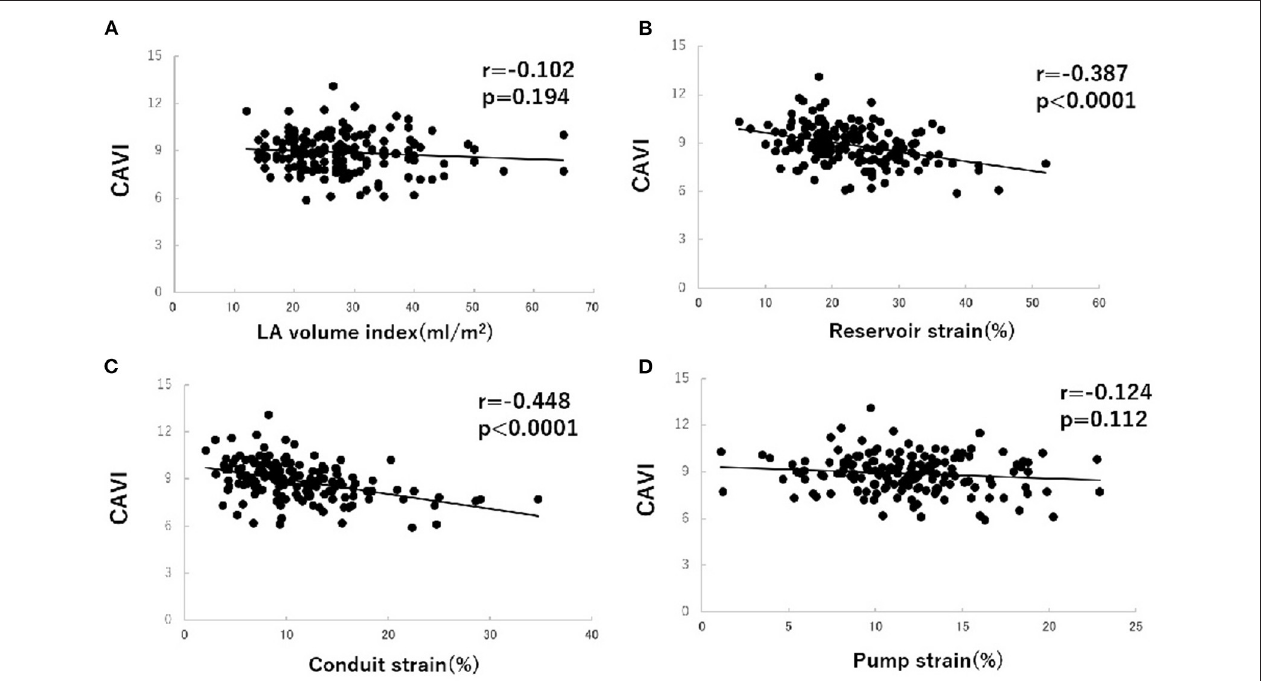
FIGURE 3 | Correlations between cardio-ankle vascular index (CAVI) value and left atrial (LA) volume index (A) , LA phasic function (B–D) in hypertensive patients with preserved ejection fraction. CAVI, cardio-ankle vascular index; LA, left atrium.